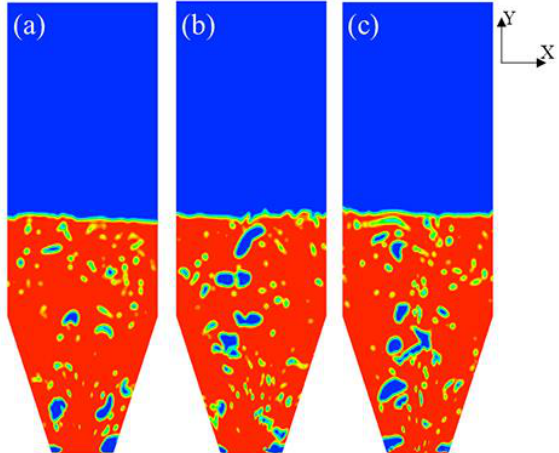
Figure 6. Distribution of bubbles at different liquid viscosities; ( a ) 0.0055 Pa·s, ( b ) 0.0100 Pa·s, ( c ) 0.0500 Pa·s.